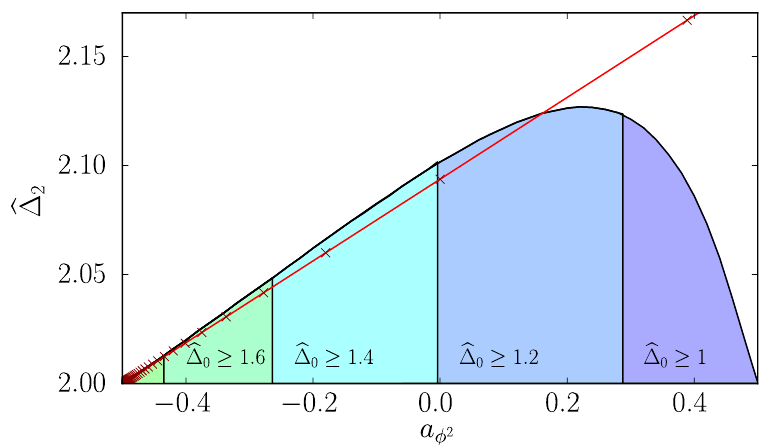
Figure 2. The maximum spin 2 gap for five choices of the imposed scalar gap. The bound is not smooth but contains a vertical line which sweeps to the left as the scalar gap is increased. The red crosses emanating from the left are the Dirichlet deformations of the m ’th minimal model, eq. (3.21), extrapolated down to m = 3 (the rightmost